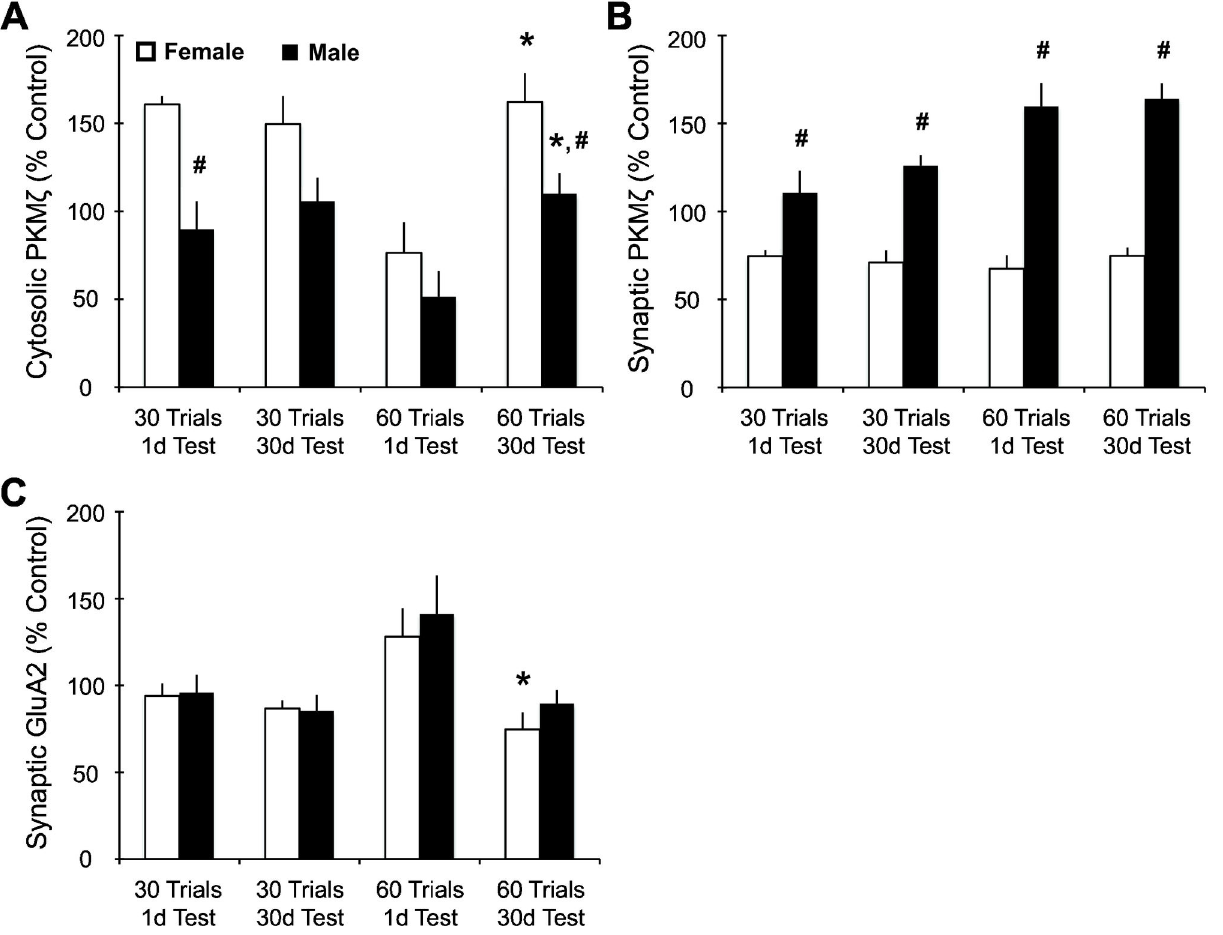
Figure 3. RAM training induces differential PKMζ and GluA2 expression between sexes in the hippocampus. (A) Cytosolic PKMζ levels showed significant sex, training and retention period effects. In the post-hoc analysis, both males and females trained for 60 trials and tested 30d later showed a significant increase in cytosolic PKMζ expression compared to 60 trials / 1d test subjects. Females from both the 60 trials / 30d and 30 trial / 1 d condition showed significantly higher levels of PKMζ compared to males of the same conditions. (B) Synaptic PKMζ levels showed significant sex and training effects. Across all conditions males show significantly higher levels of synaptic PKMζ compared to females. (C) Synaptic GluA2 levels showed significant training and retention period effects. In addition, females trained for 60 trials and tested 30d later showed a significant decrease in GluA2 expression compared to 60 trials / 1d test females. For all graphs, pound (#) denotes significant sex difference compared to females in the same training/testing condition. Asterisk (*) denotes significance compared to same-sex counterparts in the 60 trial / 1d test